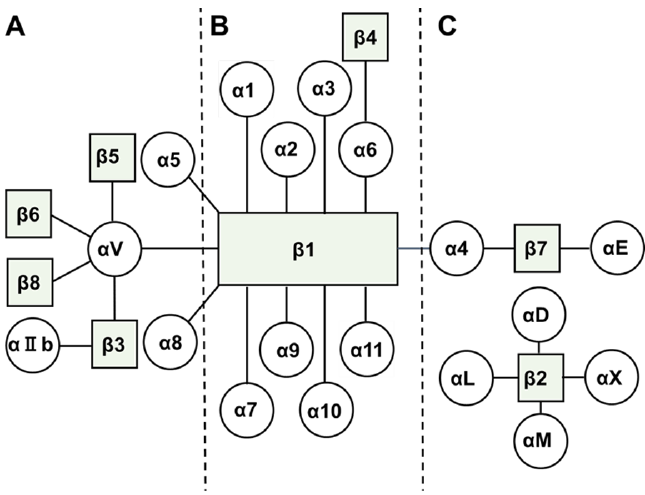
Figure 1. Members of integrin family and their interactions to form heterodimeric integrins [7]. ( A ) Integrins are roughly grouped into three classes and bind to provisional extracellular matrix, ( B ) basal extracellular matrix, and ( C ) cell surface adhesion molecules.